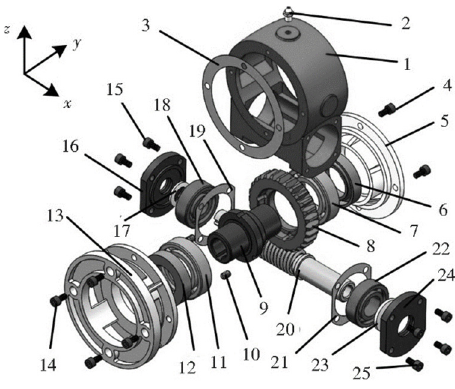
Figure 7. Drawing of worm reducer. Table 2. Parts of turbine reducer.